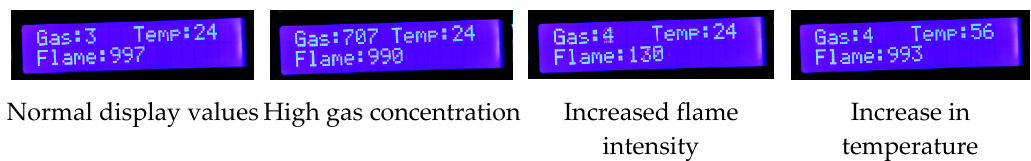
Figure 14. Changes of gas concentration, light intensity and temperature.